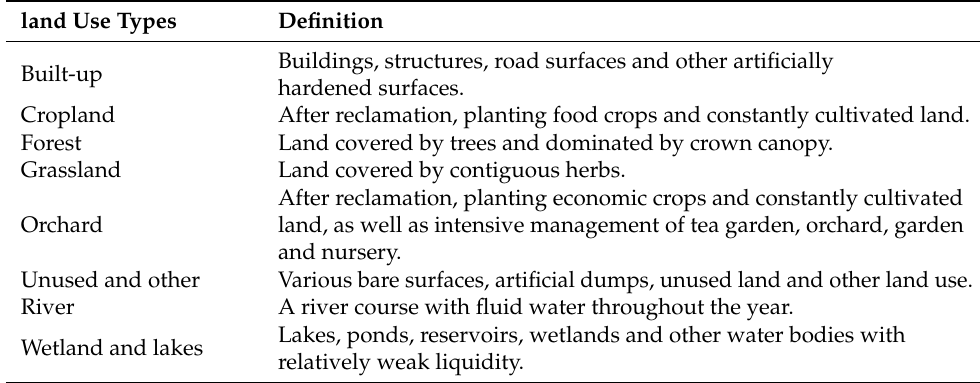
Table 1. Land use categories in the study